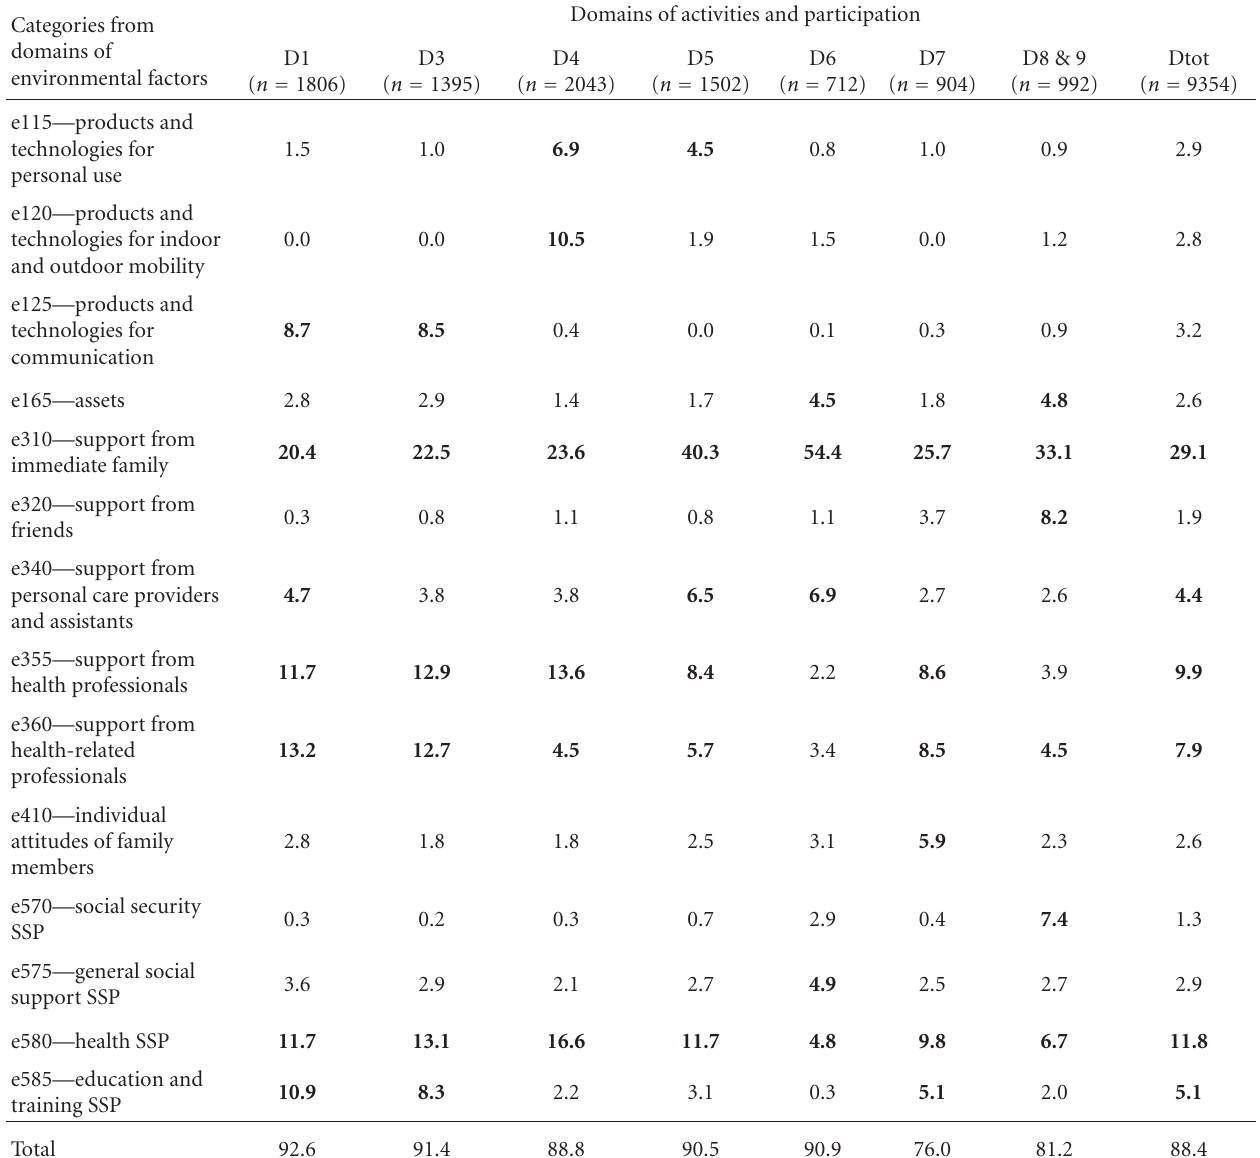
Table 3: Mean percentage of EF categories reported for each domain of A &